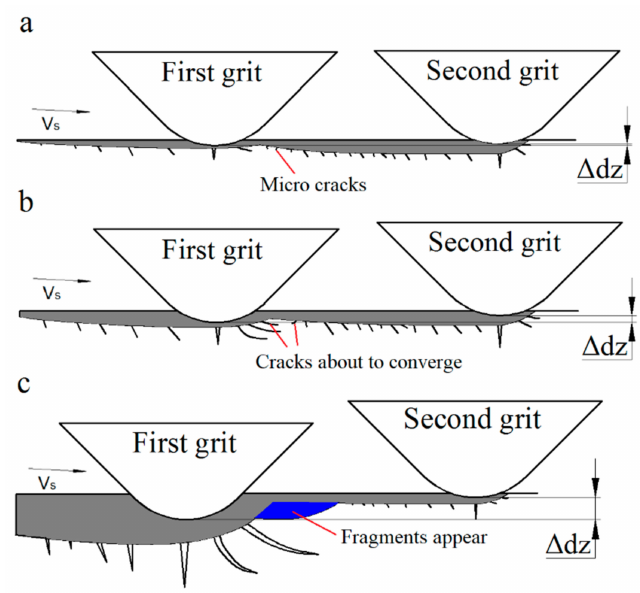
Figure 8. Material damage interference forms in micron scale with di ff erent Z-axis spacings along the DOC direction, ( a ) the first stage, ( b ) the second stage, and ( c ) the third